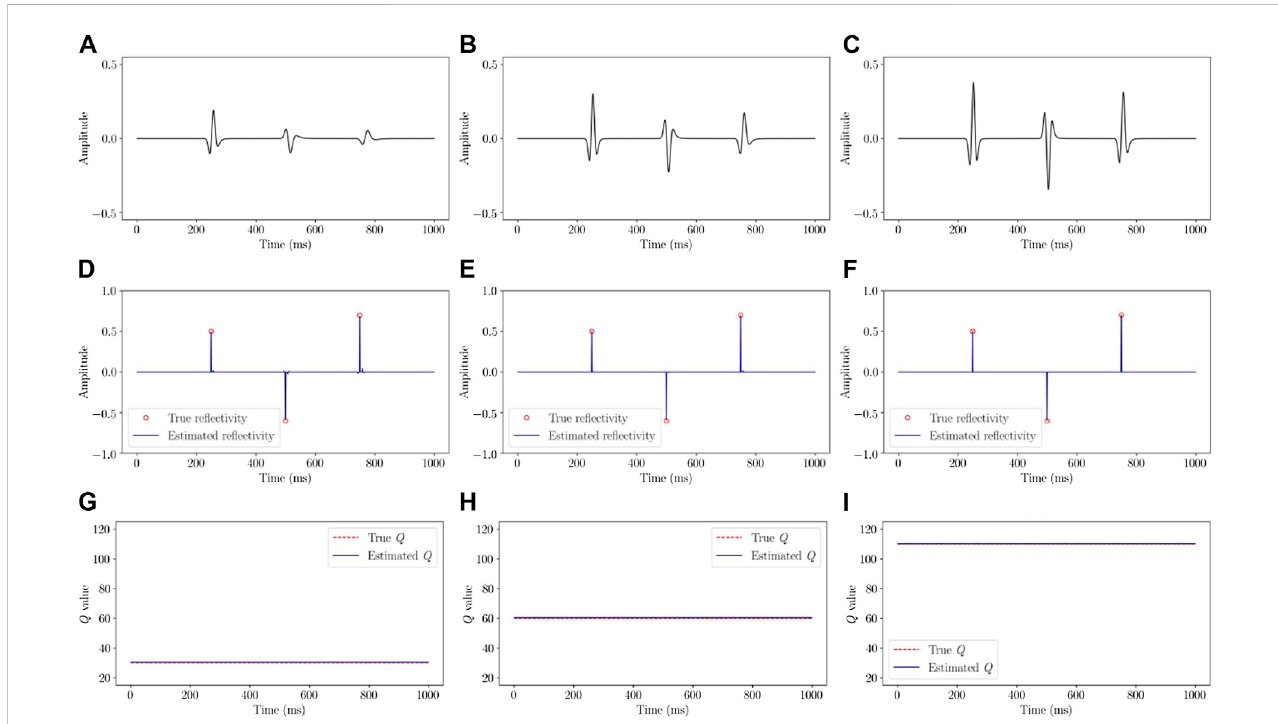
FIGURE 3 Simple synthetictraces attenuatedby using constant- Q model with different Q values: (A) Q = 30, (B) Q = 60, and (C) Q = 110. The estimated re fl ectivity series are shown in (D – F) . The true non-zero re fl ectivity coef fi cients are shown by the red points. The corresponding estimations of the Q values are showed in (G – I) . The true Q values are shown in red lines.